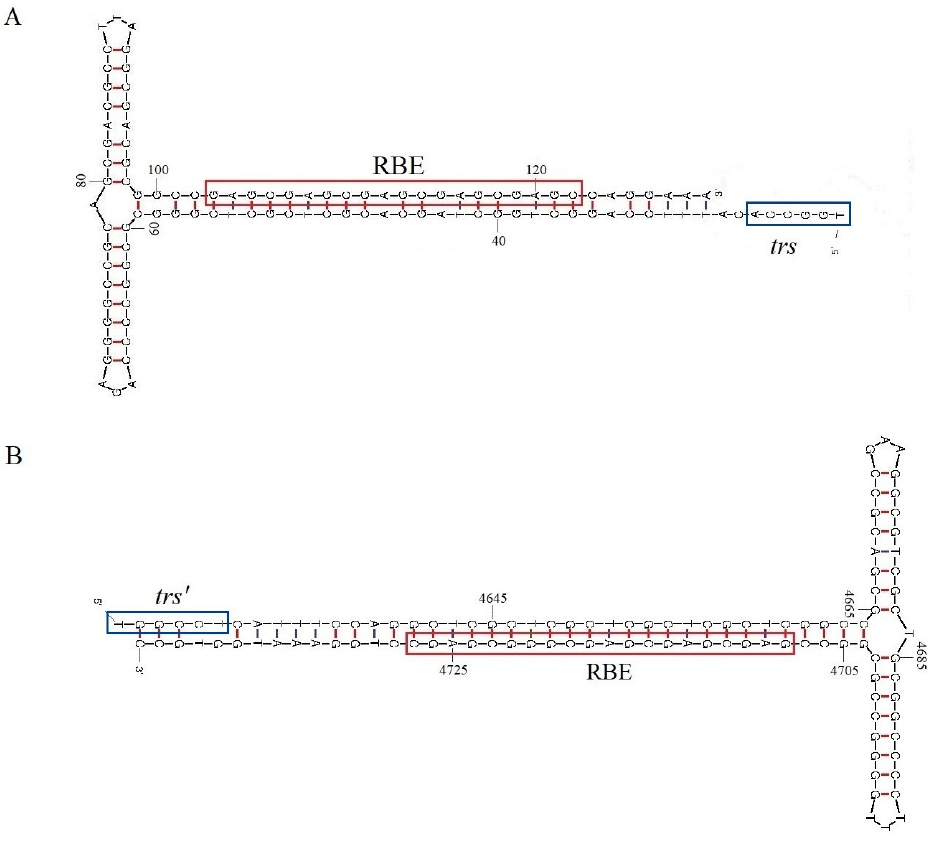
Figure 1. Inverted terminal repeats of the 5 (cid:48) ( A ) and 3 (cid:48) ( B ) termini of Sp_PsDPV. The Rep Binding Element (RBE) and the Terminal Resolution Site (trs) are enclosed in boxes.